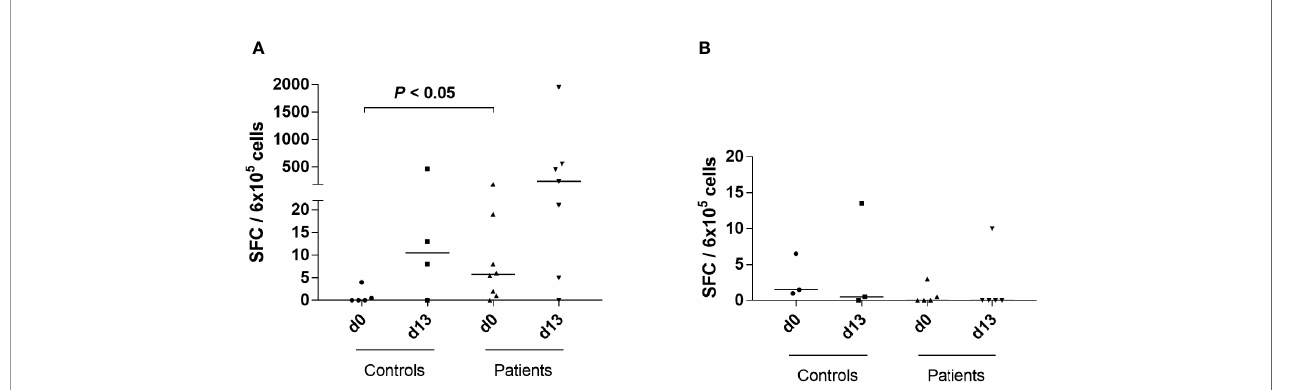
FIGURE 2 | Increased IFN g responses to LLNATIAEV, but not EPLARLEL, in patients with AAD. (A) PBMCs from HLA-A2 positive individuals were stimulated with LLNATIAEV peptide ex vivo (AAD patients n = 8, controls n = 5) or restimulated following 13 days of peptide-induced in vitro expansion (AAD patients n = 7, controls n = 4). (B) PBMCs from HLA-B8 positive individuals were stimulated with EPLARLEL peptide ex vivo (AAD patients n = 5, controls n = 3) or restimulated following 13 days of peptide-induced in vitro expansion (AAD patients n = 5, controls n = 3). The number of IFN g -secreting cells (SFC) was measured by ELISPOT and is